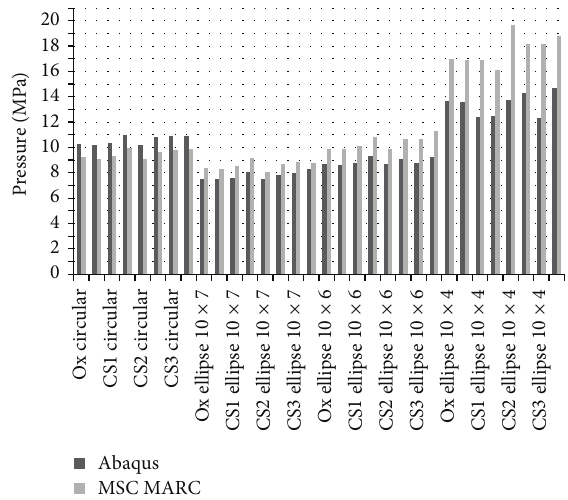
Figure 22: Applied pressure for the bulge tests using Abaqus and MSC-MARC.